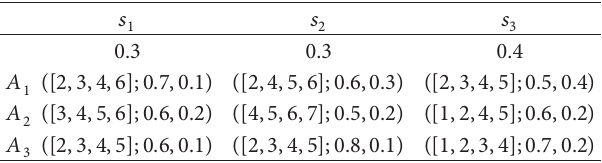
Table 3: Prospect information for attribute 𝑐 3 .